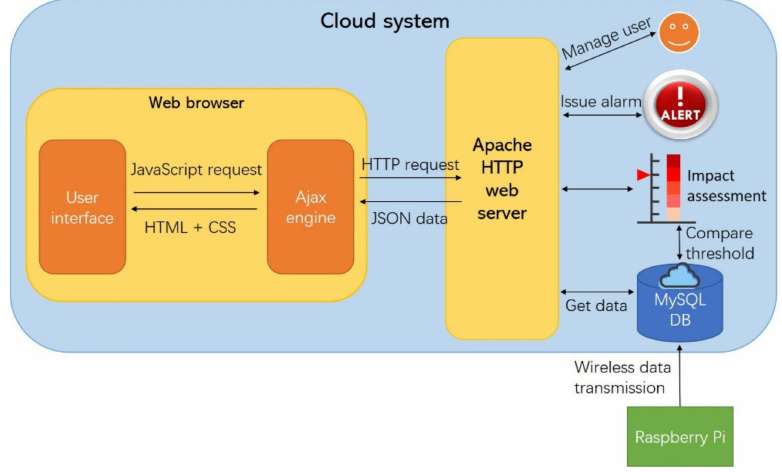
Figure 9. Cloud system